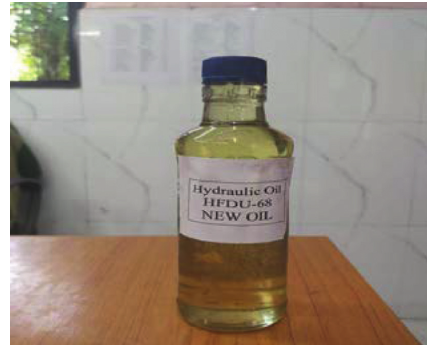
Figure 5: New oil sample.